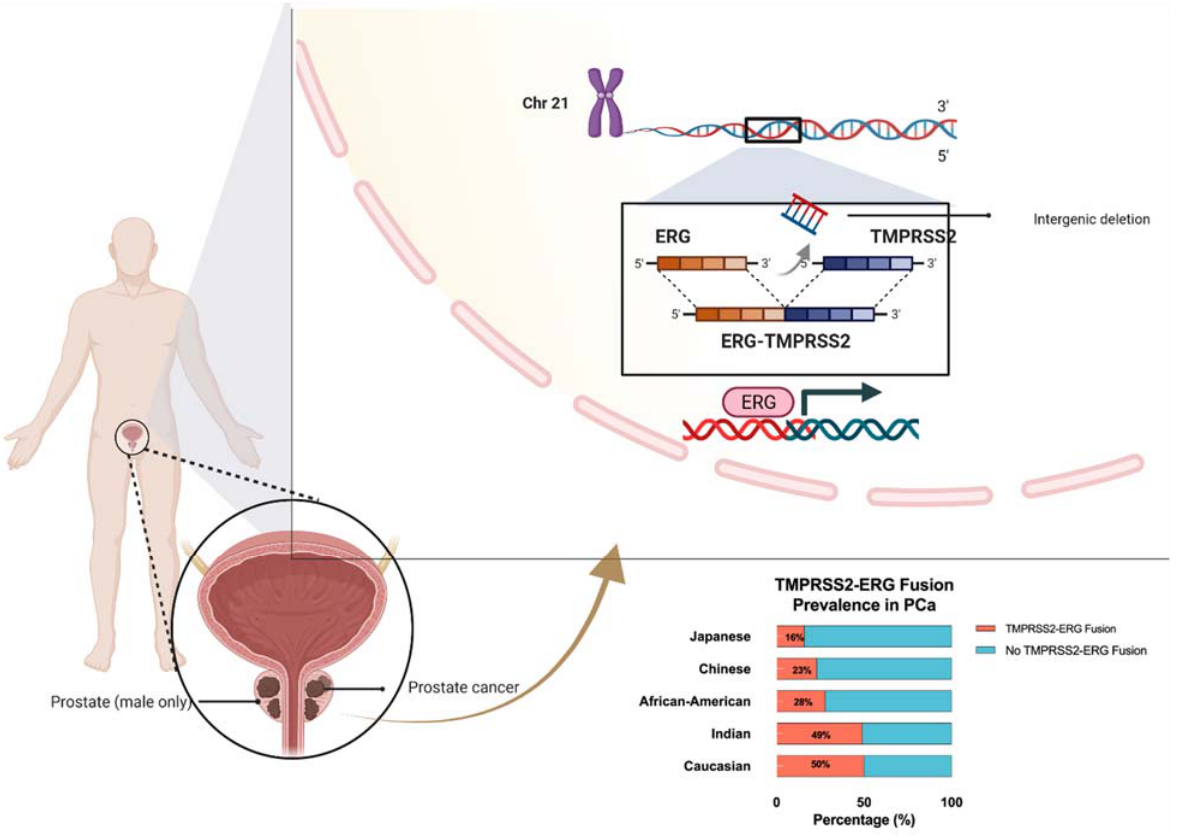
Figure 1. Schematic diagram of TMPRSS2 ‐ ERG gene fusion on chromosome 21 and the ethnic prevalence of TMPRSS2 ‐ ERG gene fusion in prostate cancer patients.